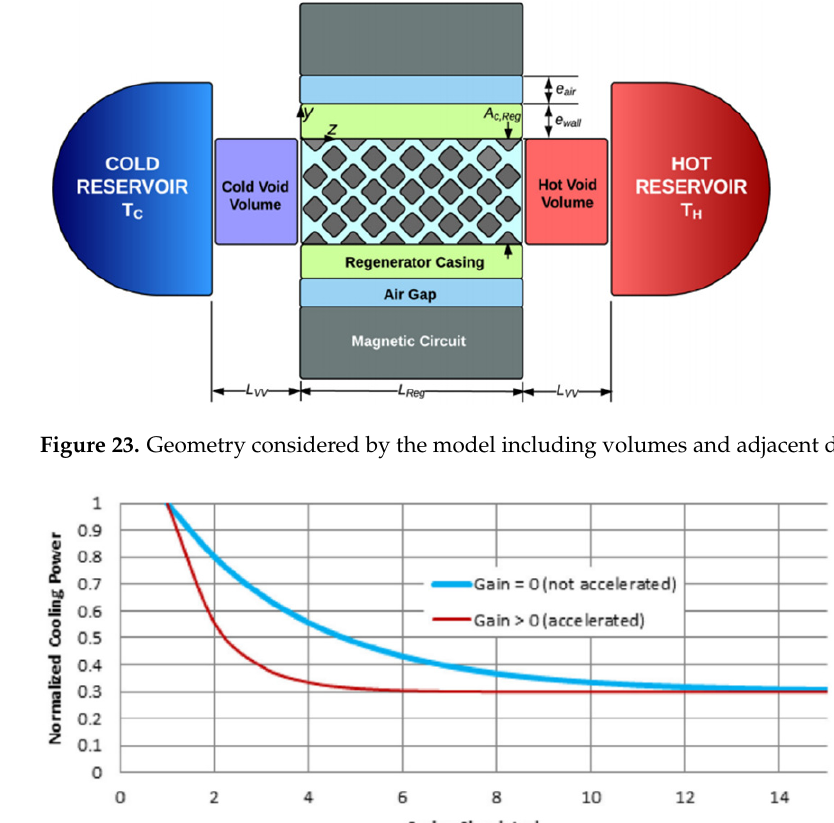
Figure 24. Observation of the influence of the convergence acceleration on the model output [83]. The convergence appears when the curves reach a set value. Roy et al. (2017) [85] developed a 1-D model to study a parallel plate regenerator and to optimize its performances. Several parameters are retained, such as the mass flow rate and the thickness of the plate and the fluid duct. They obtained optimal results with a good computation time with a genetic algorithm. For this, they used a multi-objective op- timization with MATLAB ® . Teyber et al. (2018) [109] developed a semi-analytical AMRR model. The model was implemented in Python using the open-source SciPY package [110]. Their goal was to screen the best operating conditions and regenerator compositions, in order to perform an optimization of the multi-layer AMRR. The semi-analytical model was optimized with a hybrid method using firstly SciPY and then the sequential least squares quadratic pro- gramming method. The studied device is composed of two cylindrical multi-layer regen- erators. The magnetic field of the device is generated by two nested concentric Halbach